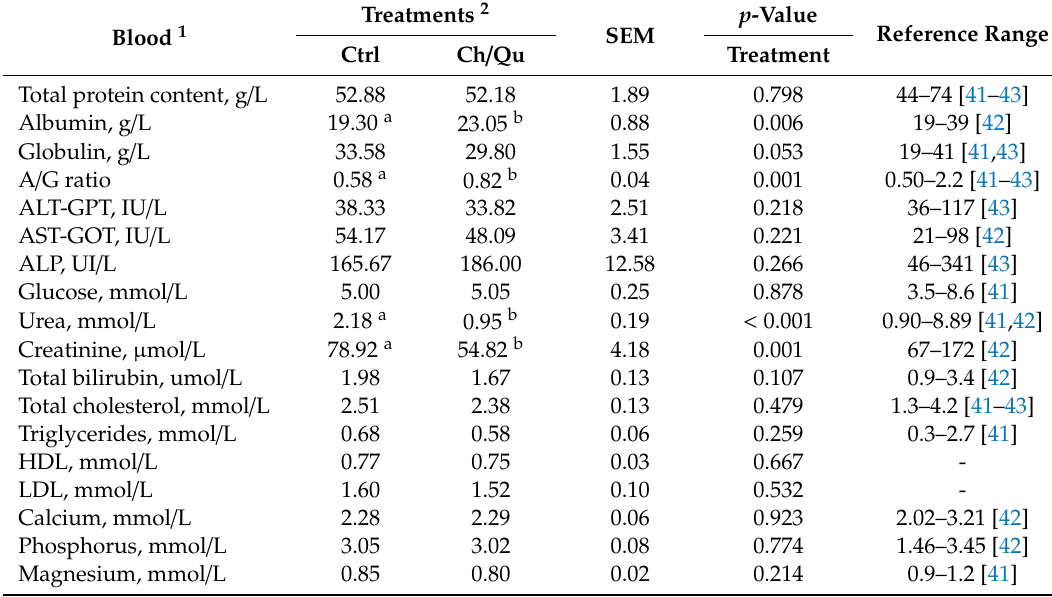
Table 4. The biochemical concentration of serum metabolites in control (Ctrl, n = 12) and tannin (Ch / Qu, n = 12) groups on day 40 of the in vivo trial (75-day-old piglets) with reference ranges for pigs.